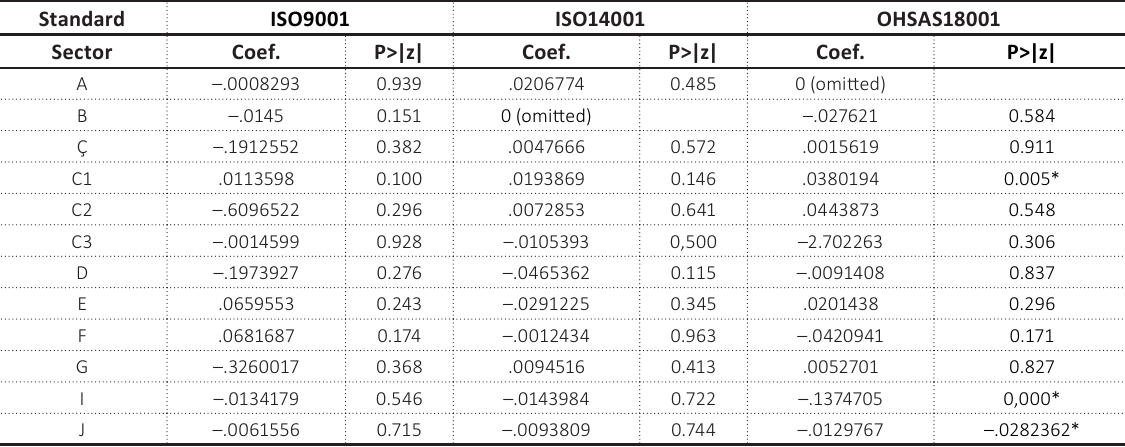
Table 8. Results of the regression model by